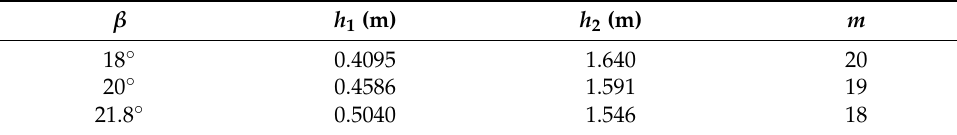
Table 1. Quantity of medicine storage tanks with different tilt angles.